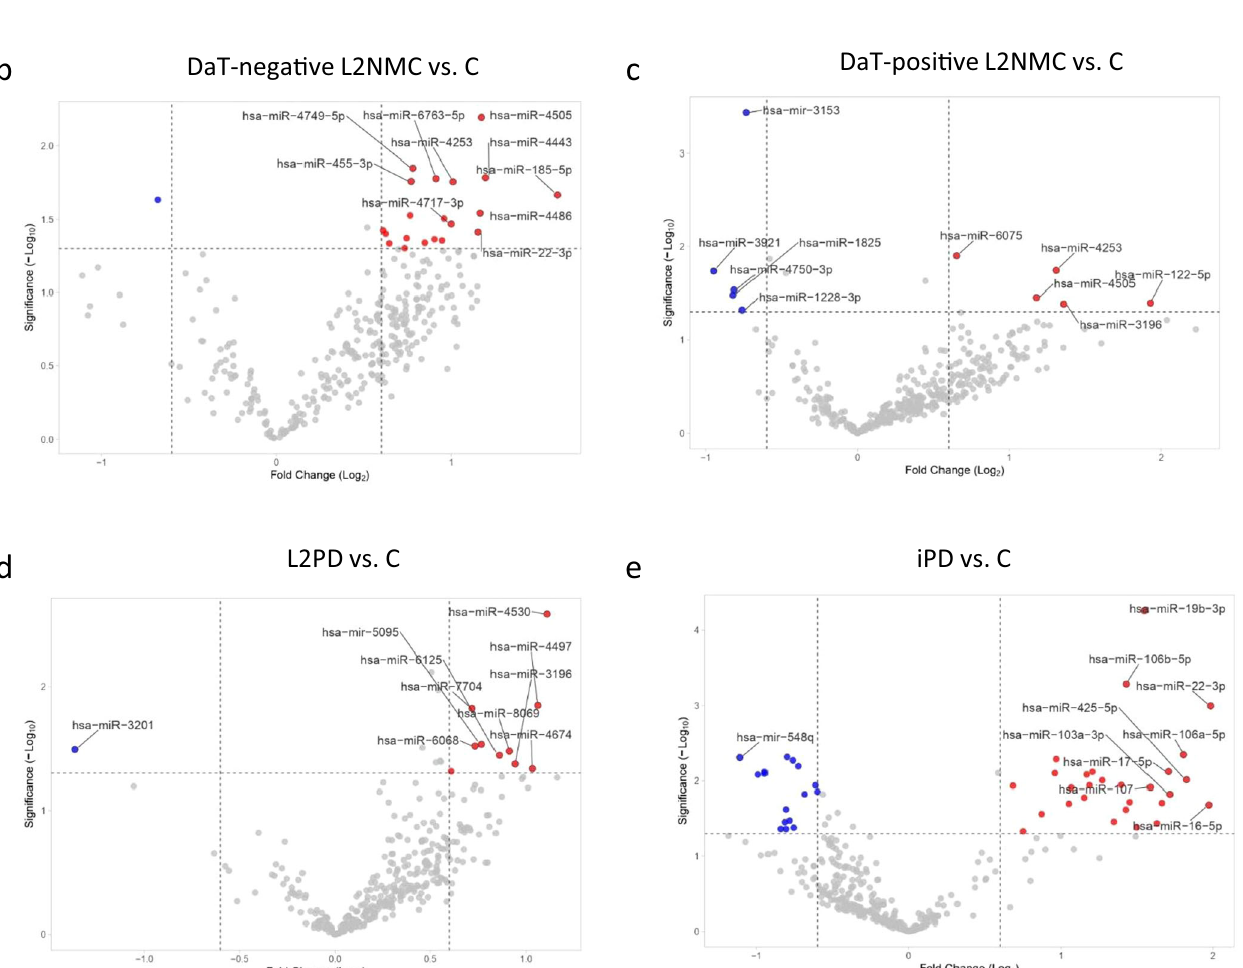
Fig. 1 Work fl ow of the study and differential miRNA expression in DaT-negative L2NMC, DaT-positive L2NMC, L2PD patients, and iPD patients by genome-wide miRNA analysis in the discovery phase. a Work fl ow of the study and number of participating subjects. b Volcano plot of differential miRNA expression between DaT-negative L2NMC and controls, c DaT-positive L2NMC and controls, d L2PD and controls, and e iPD and controls. Candidate differentially expressed miRNAs were de fi ned as miRNAs with a fold-change above |1.5| and a p value below 0.05 under a two-tailed Student ’ s t test. Only names of the top-10 miRNAs are shown. Up-regulated and down-regulated DEmiR are respectively depicted in red and blue. DaT DaT-SPECT imaging, L2NMC LRRK2 non-manifesting carriers, L2PD LRRK2-associated PD patients, iPD idiopathic PD DaT-positive L2NMC 20 showed signi fi cant miRNA variation for 11 cross-sectional serum samples as the reference (baseline) 31 , and compared it to their seriated samples after 4 (time point 2) and 8 of the 12 studied miRNAs (Table 3 and Fig. 6). More speci fi cally, 5 years (time point 3) of follow-up. Compared to their respective DEmiR showed continued expression variation which was baselines, longitudinal time points 2 and 3 from DaT-negative and consistent across both follow-up time points in DaT-negative